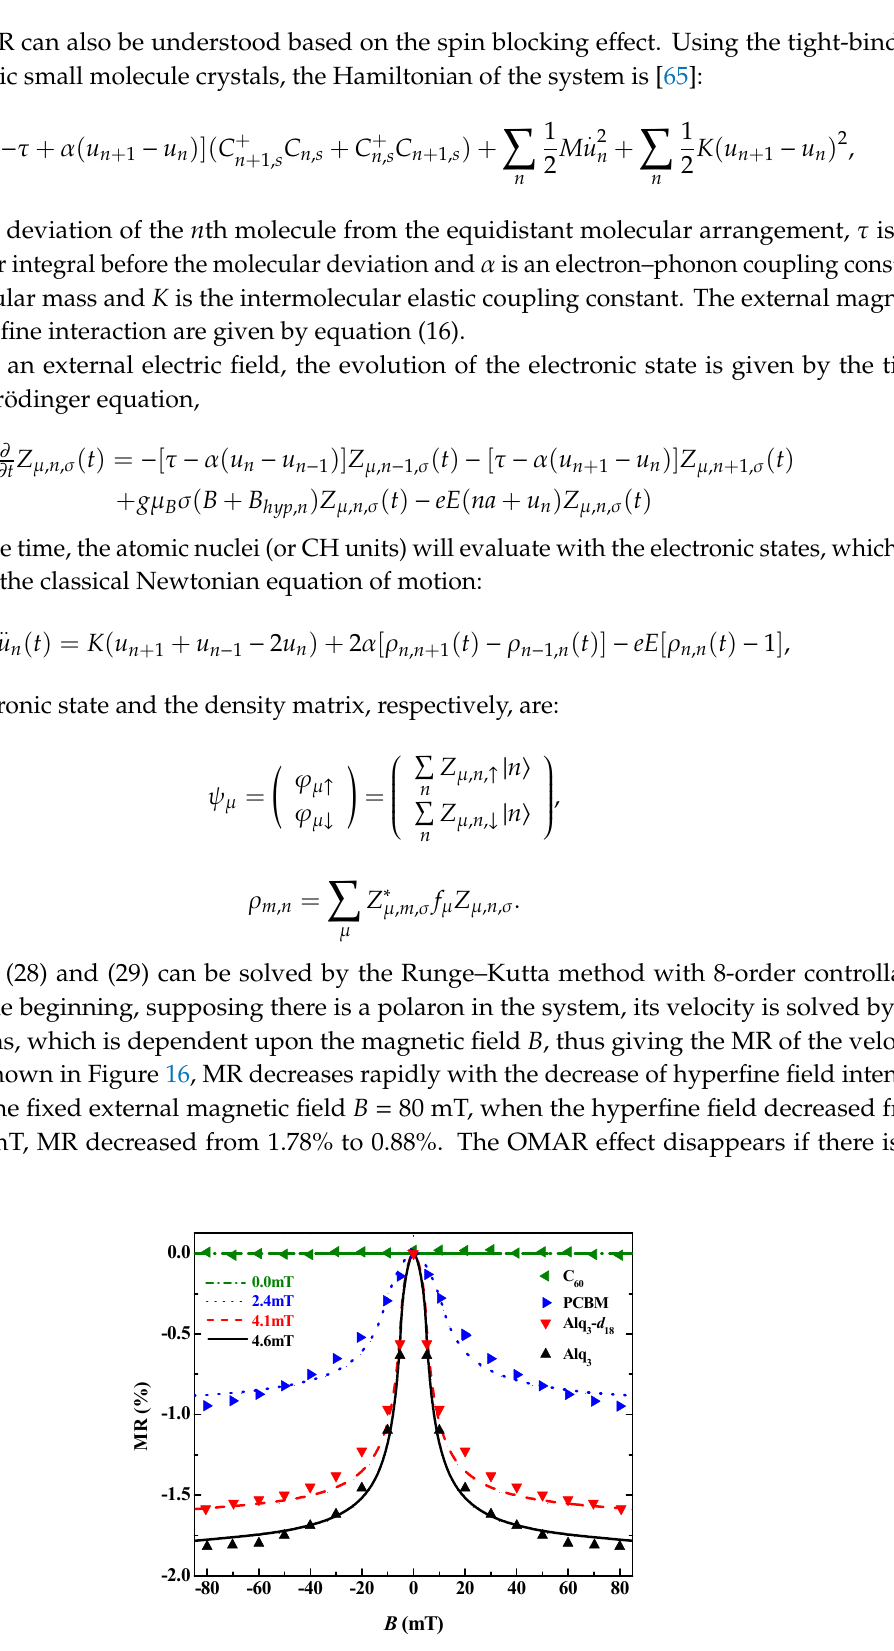
Figure 16. Dependence of MR with the magnetic field under a different hyperfine field. ▼ represents the experimental data [66,67]. The curves represent the theoretical results [65].